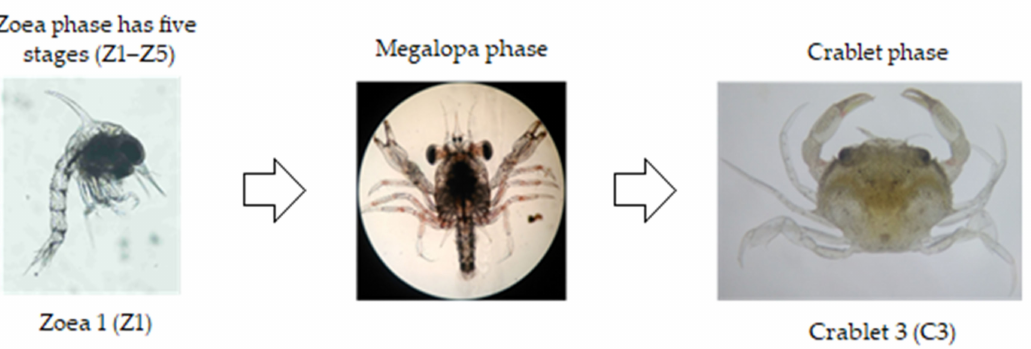
Figure 1. Larvae development of mud crabs from zoea to crablet